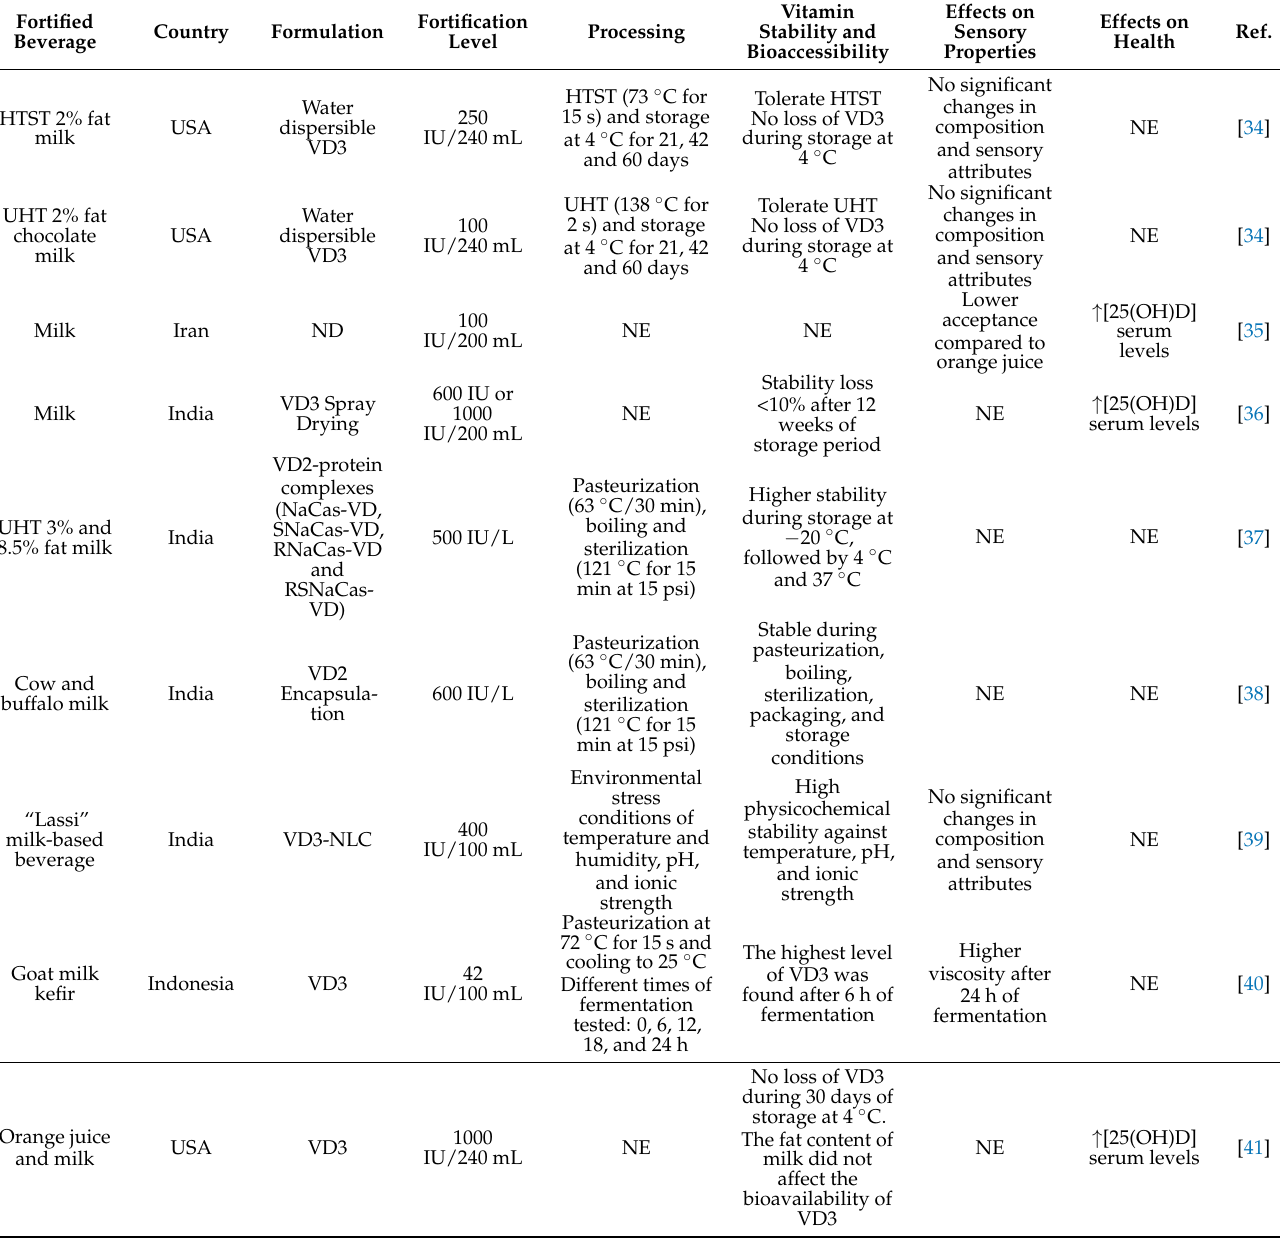
Table 1. Fortification approaches of vitamin D in different types of